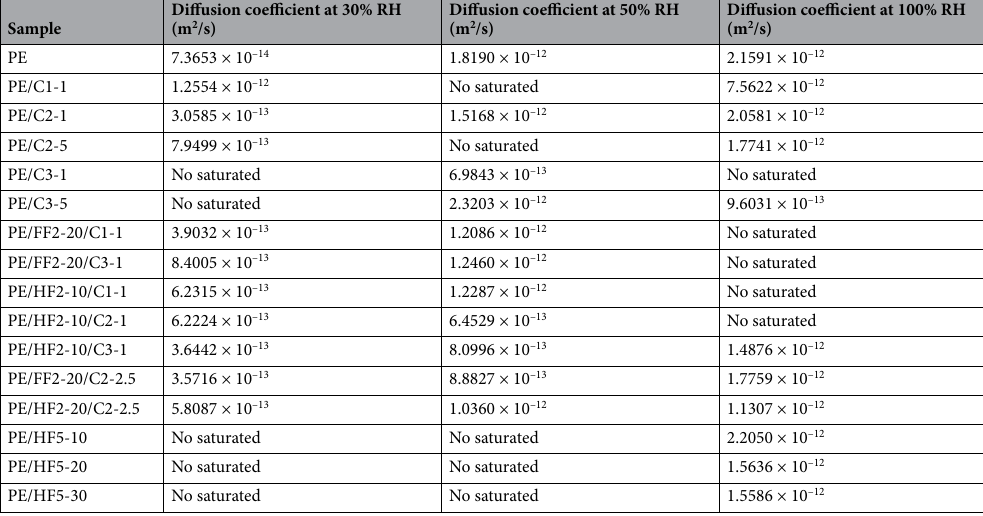
Table 3. Estimated diffusion